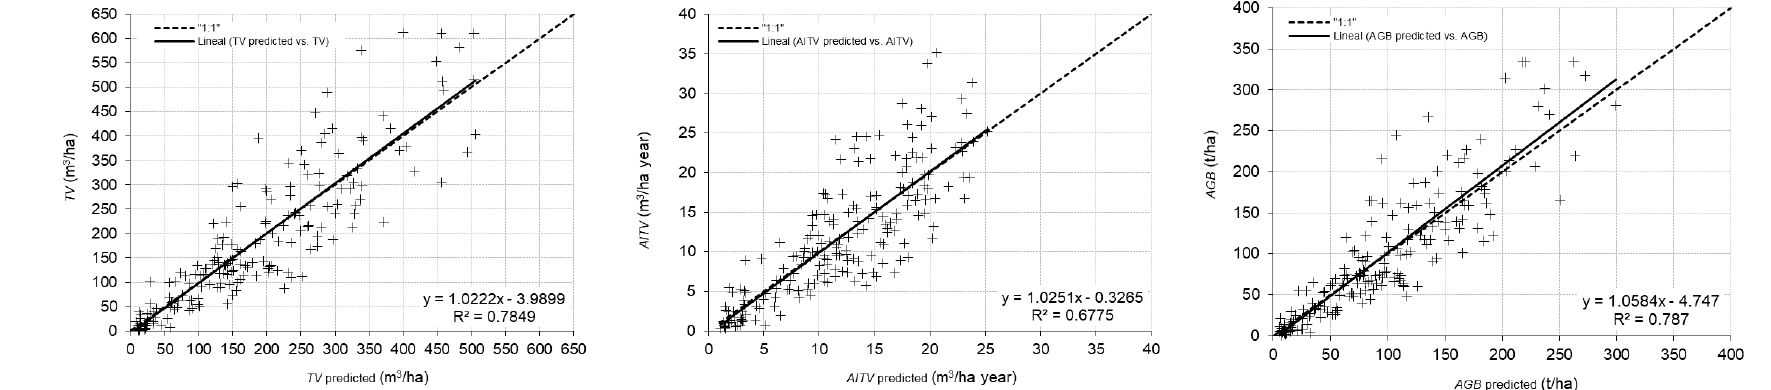
Figure 4. Plot-level predicted against observed values for the best techniques for total volume (m 3 / ha), annual increase in total volume (m 3 / ha year) and total aboveground biomass (t / ha) in E. globulus (row 1), P. pinaster (row 2) and P. radiata (row 3). The solid line represents the linear model fitted to the scatter plot of data and the dashed line represents the line of slope equal to 1.